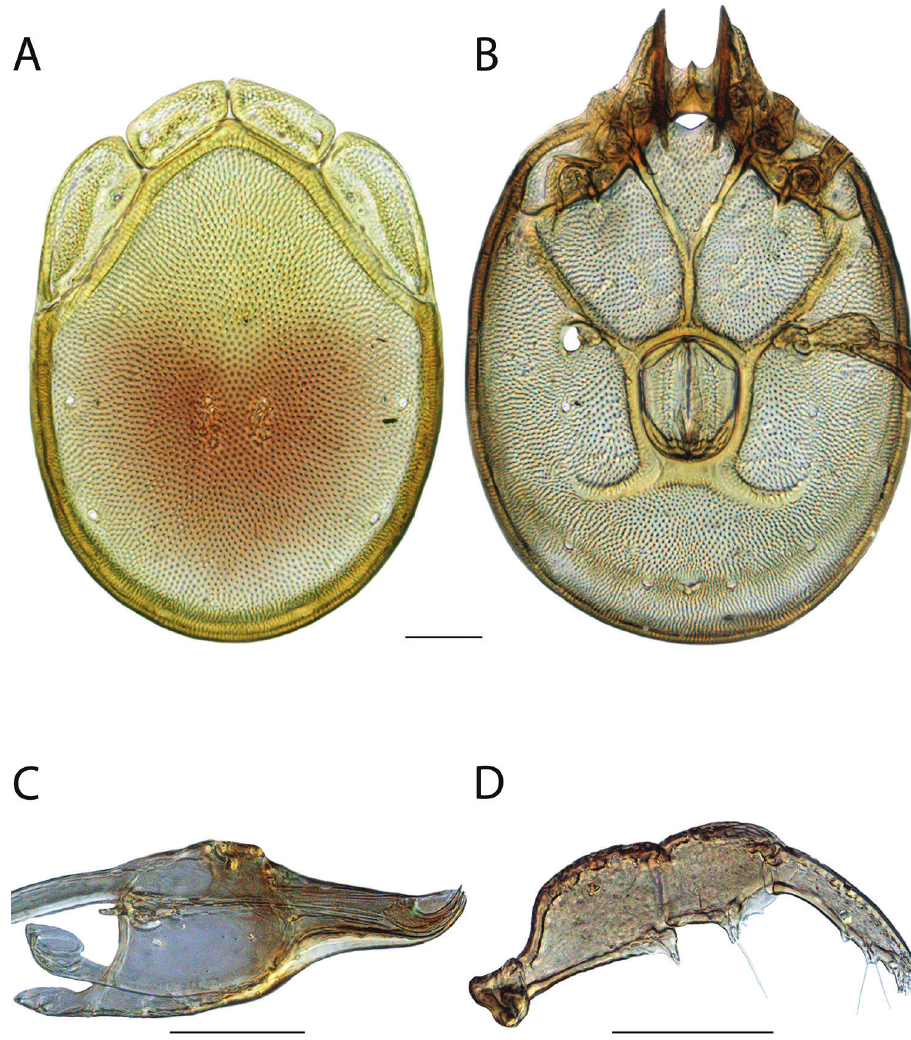
Figure 180. Torrenticola oregonensis sp. n. male: A dorsal plates B venter (legs removed) C subcapitulum D pedipalp (setae not accurately depicted). Scale = 100